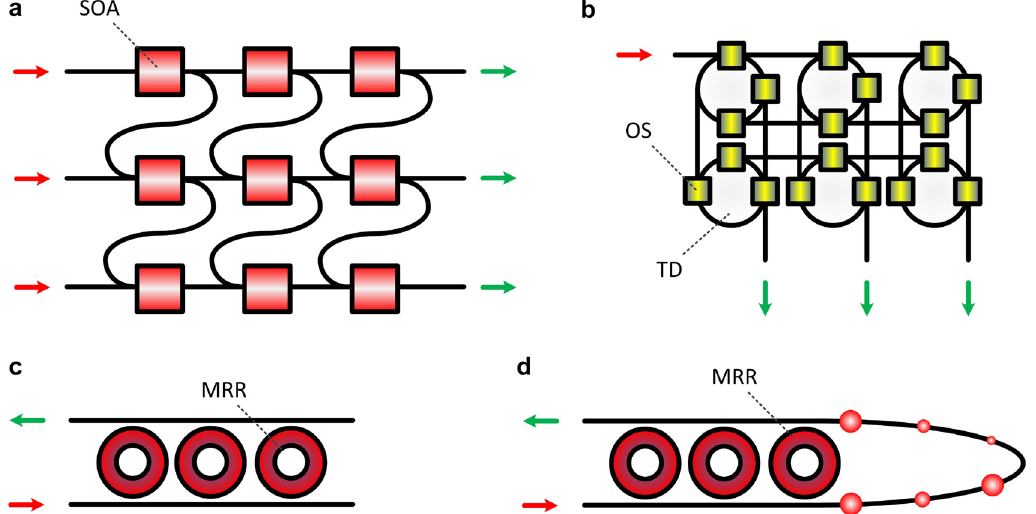
Figure 3: All-optical nonlinear (a), (c) and (d) and linear (b) topologies, with multiple real nodes, for optical information processing. (a) Mesh network of multiple nonlinear SOA. (b) Mesh network of multiple optical splitters (OS) and different time delays (TD). (c) MRR array with different MRR elements and intra-MRR delays. (d) MRR array with different MRR elements and external optical